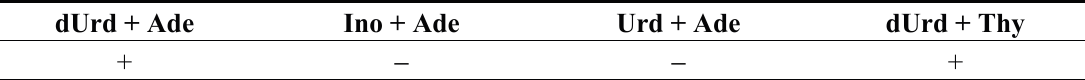
Table 1. Nucleoside 2'-deoxyribosiltransferase activity of Bp NDT. dUrd + Ade Ino + Ade Urd + Ade dUrd + Thy + − − + Experimental conditions: 0.40 μ g of enzyme were incubated at 40 °C for 5 min with 40 μ L of 10 mM substrates in 50 mM MES buffer, pH